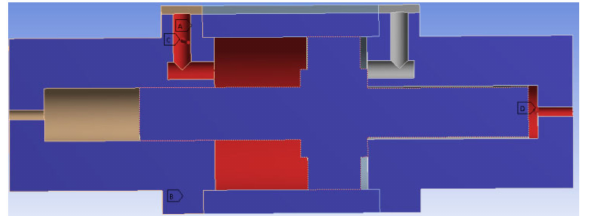
Figure 10. The piston is at the far right.